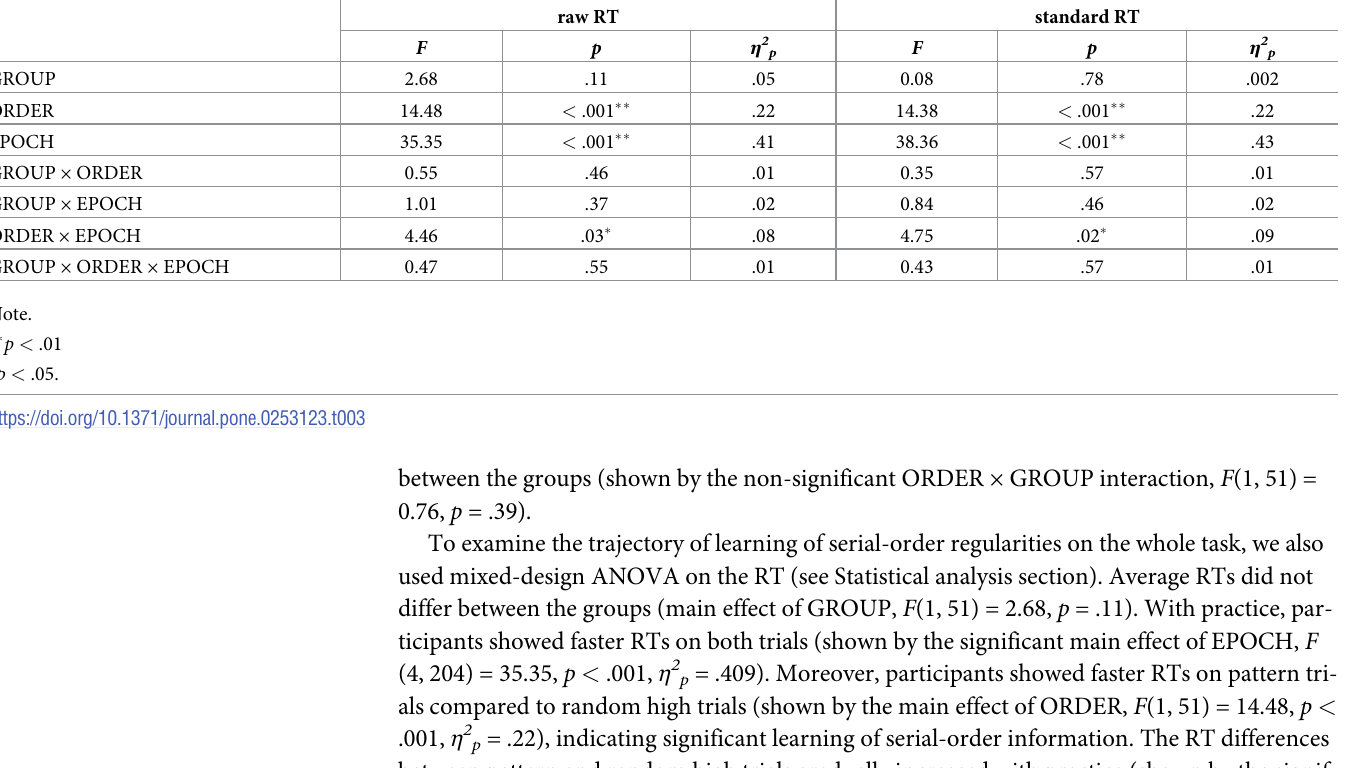
Table 3. Summary of results from ANOVAs performed on raw RT and standard RT data considering learning of serial-order regularities.